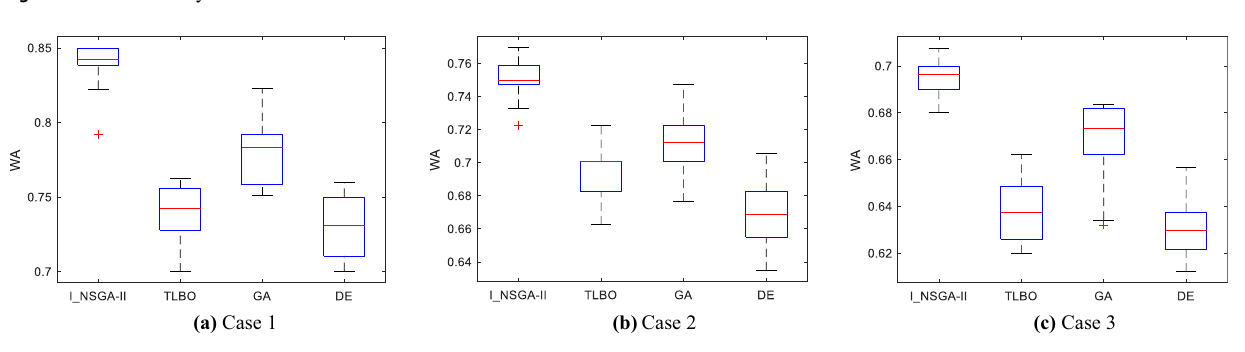
Fig. 8 Wave availability calculation function